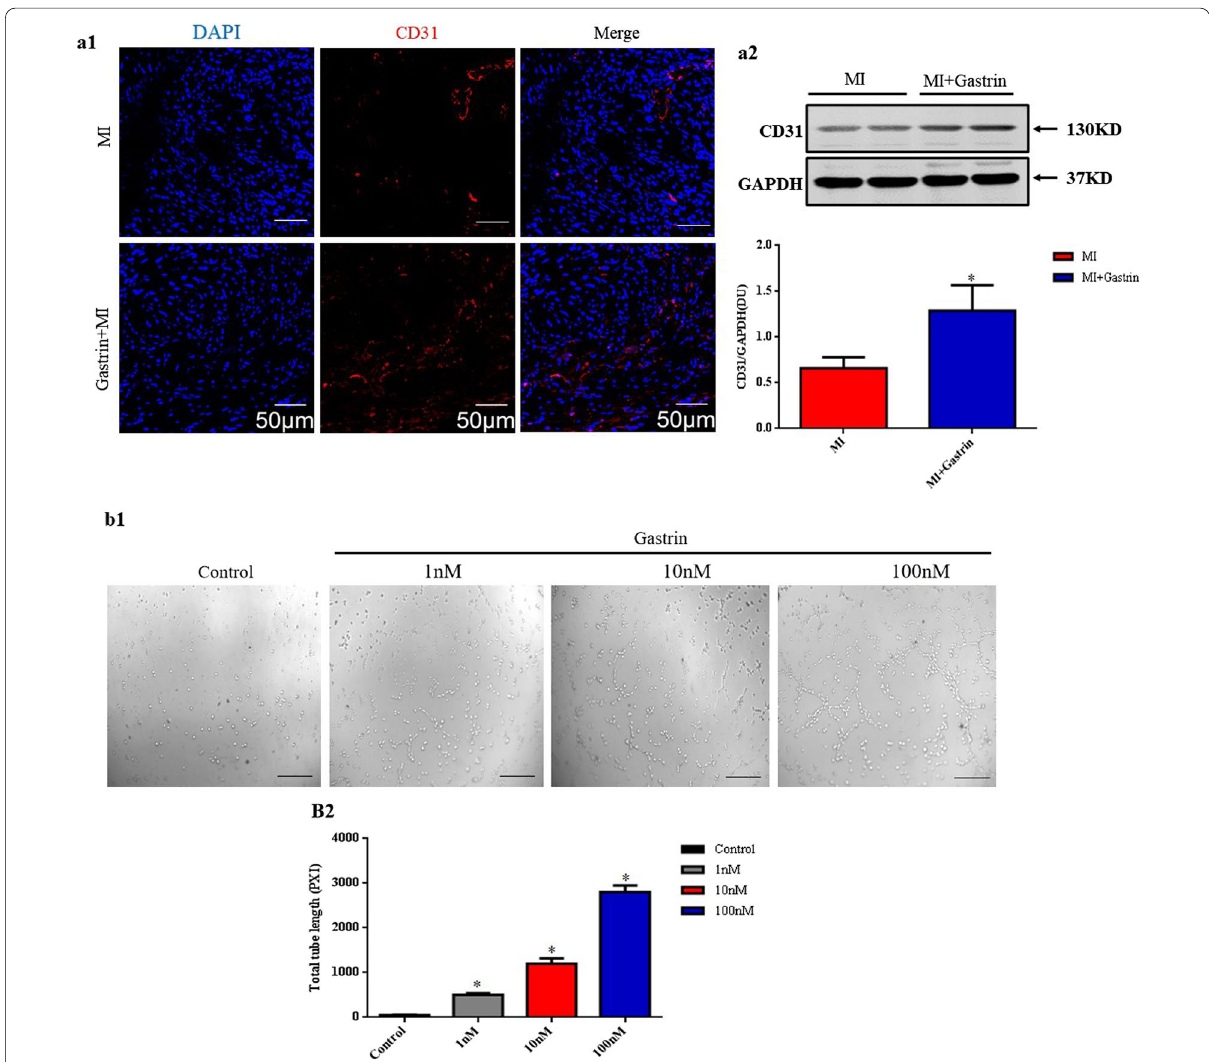
Fig. 4 Gastrin induces angiogenesis after myocardial infarction. a1 Immunofluorescence staining with anti-cluster of differentiation 31 (CD31) antibody showed the microvessel densities in the infarcted border zone 14 days after MI. DAPI is blue, and CD31 is red. Scale bar Western blot was used to measure the protein levels of CD31 in the infarcted border zone of the heart 14 days after MI. Results are expressed as the ratio of CD31 to GAPDH. n 8. * P < 0.05, vs. MI mice. b Human coronary artery endothelial cells (HCAECs) were incubated with gastrin at the = indicated concentrations. Representative images ( b1 ) and quantification ( b2 ) of tube formation assay with HCAECs. Scale bar * P < 0.05, vs.